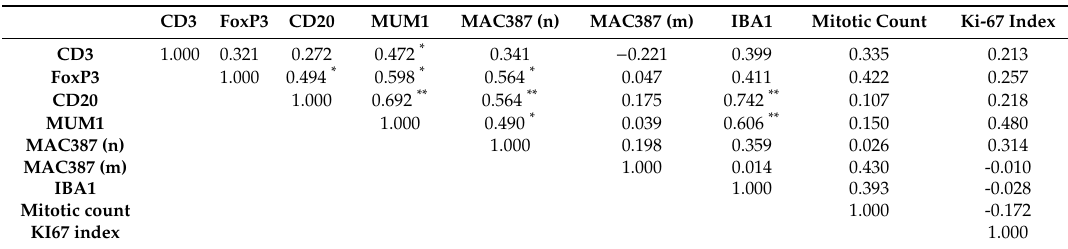
Table 5. Correlation analysis (Spearman rank correlation coefficient, ρ ). All of the values are referred to intratumoral positive cells. (n) = neutrophils; (m) = macrophages.